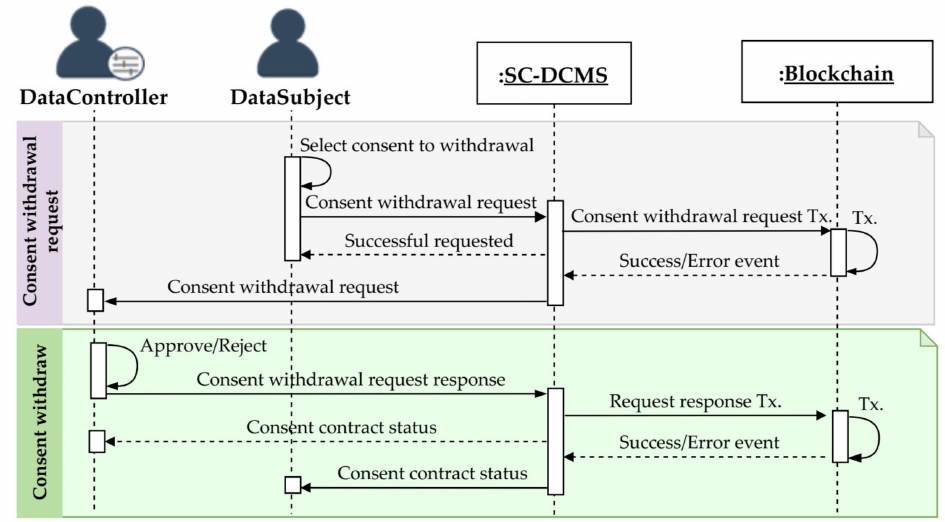
Figure 5. Consent withdrawal sequence diagram of the